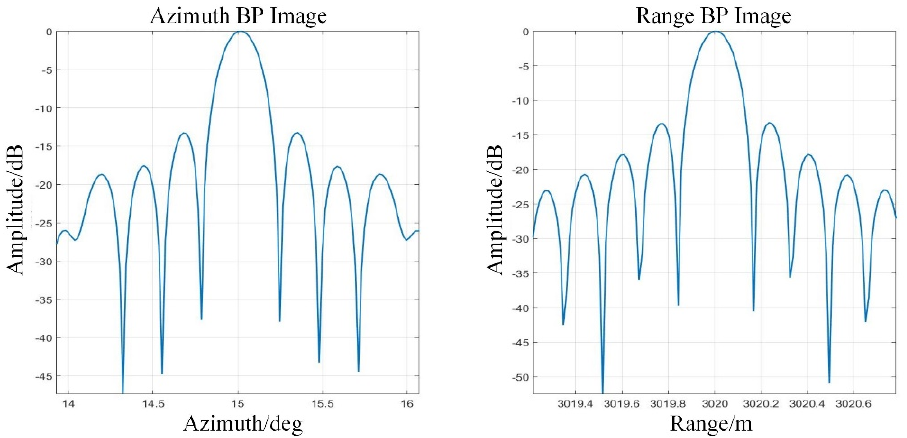
Figure 7. BP image result after element position error estimation and compensation ( a ) element position estimation accuracy; ( b ) image after error compensation.